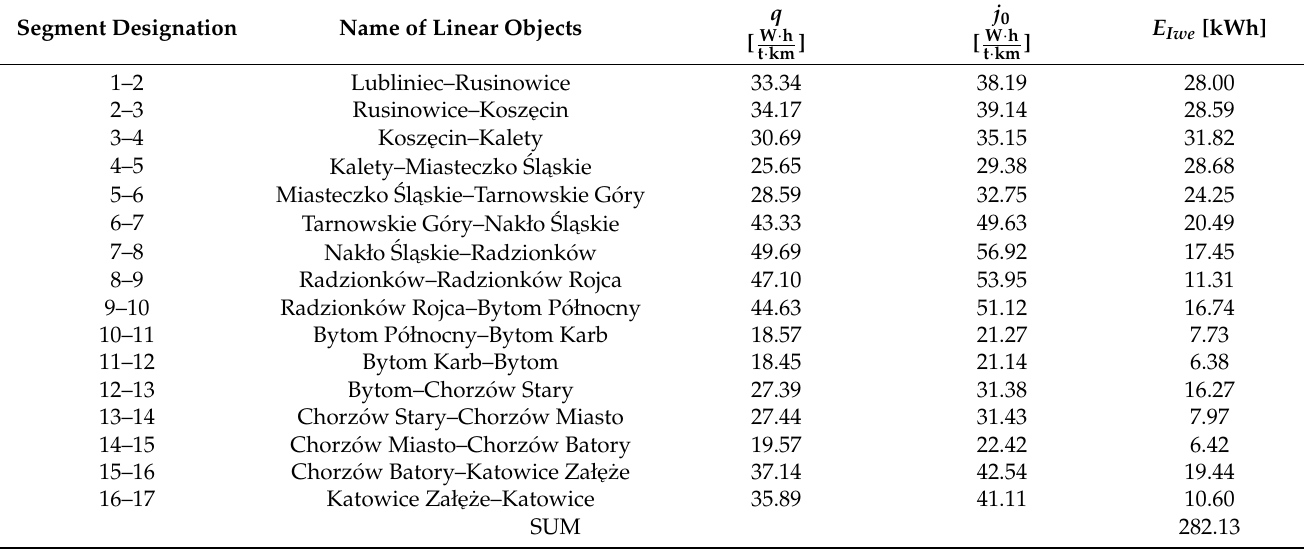
Table 2. Variant I: calculated electricity consumption values q , j 0 , and E Iwe